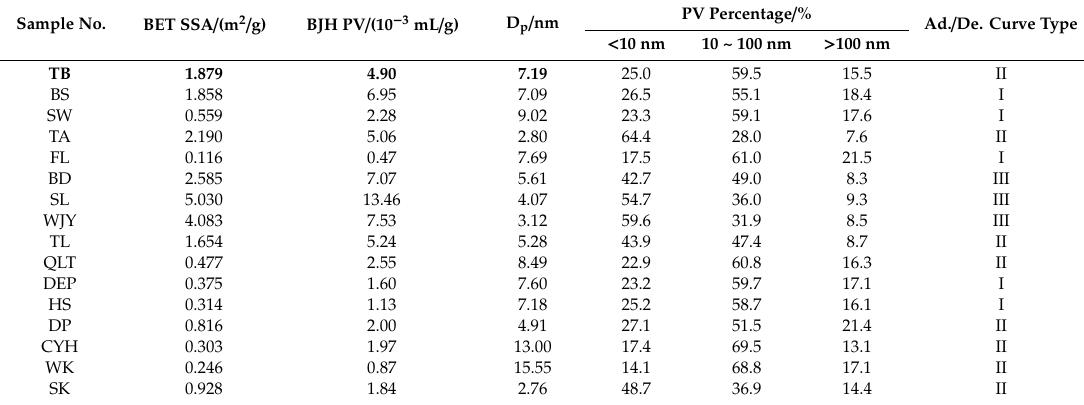
Table 2. Experiment porosity test results by nitrogen adsorption (N 2 GA).